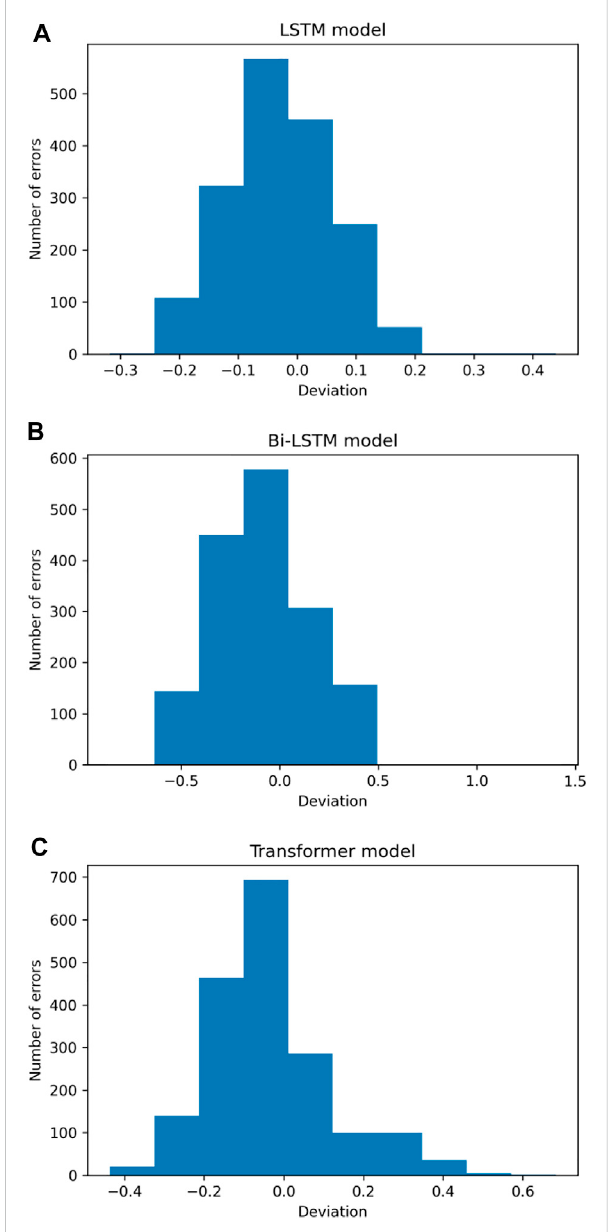
FIGURE 20 Plot of observed magnitude against anticipated magnitude utilizing (A) LSTM, (B) Bi-LSTM, and (C) transformer models on the HKKH region earthquake catalogue.